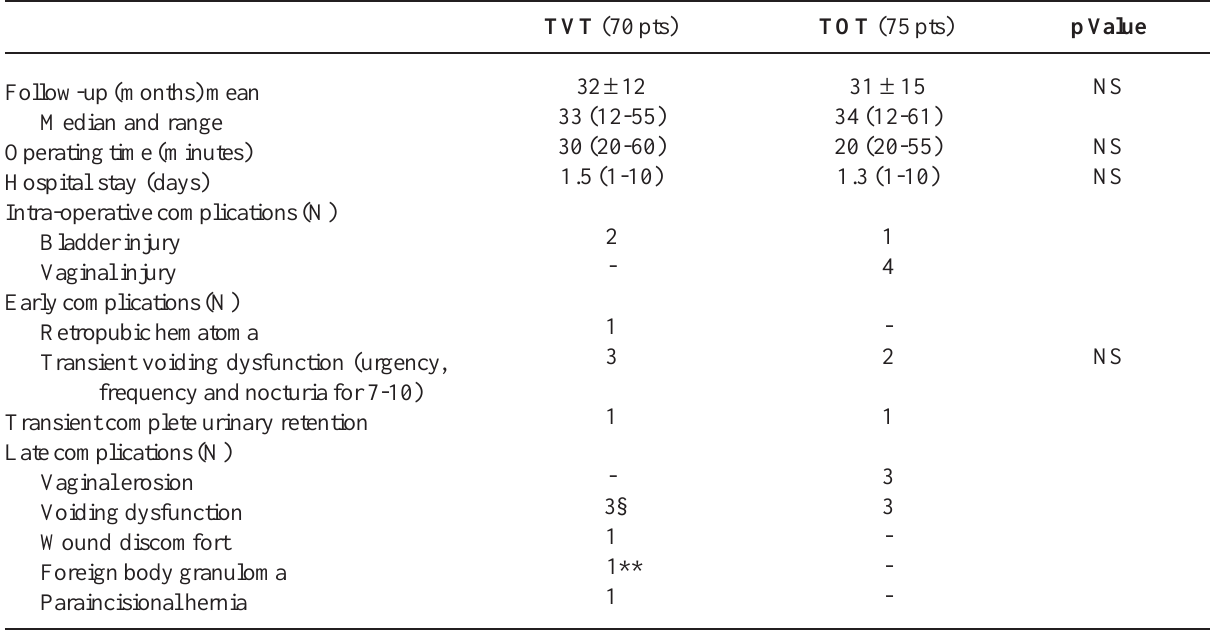
Table 3 – Operative data and postoperative morbidity (median and